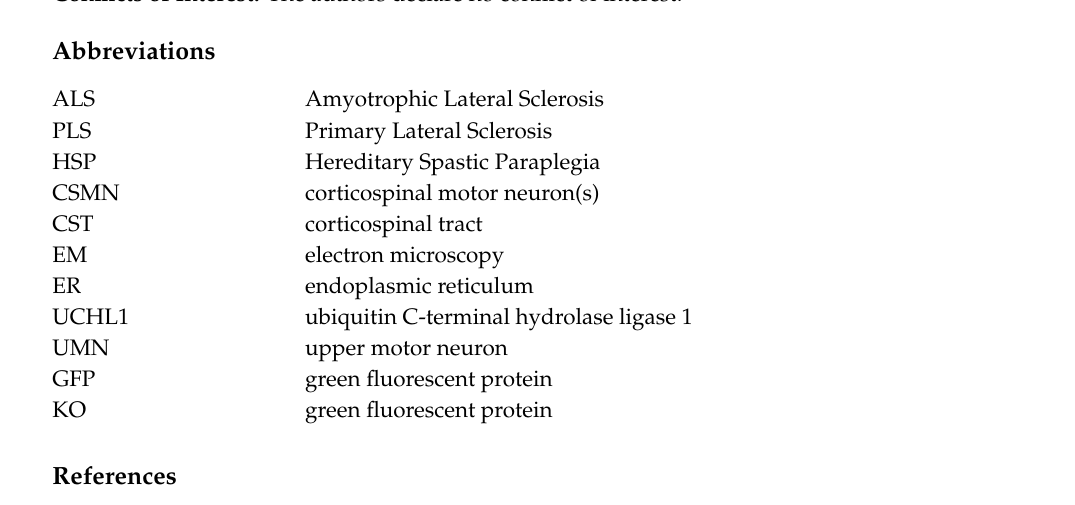
table. B.G. prepared the